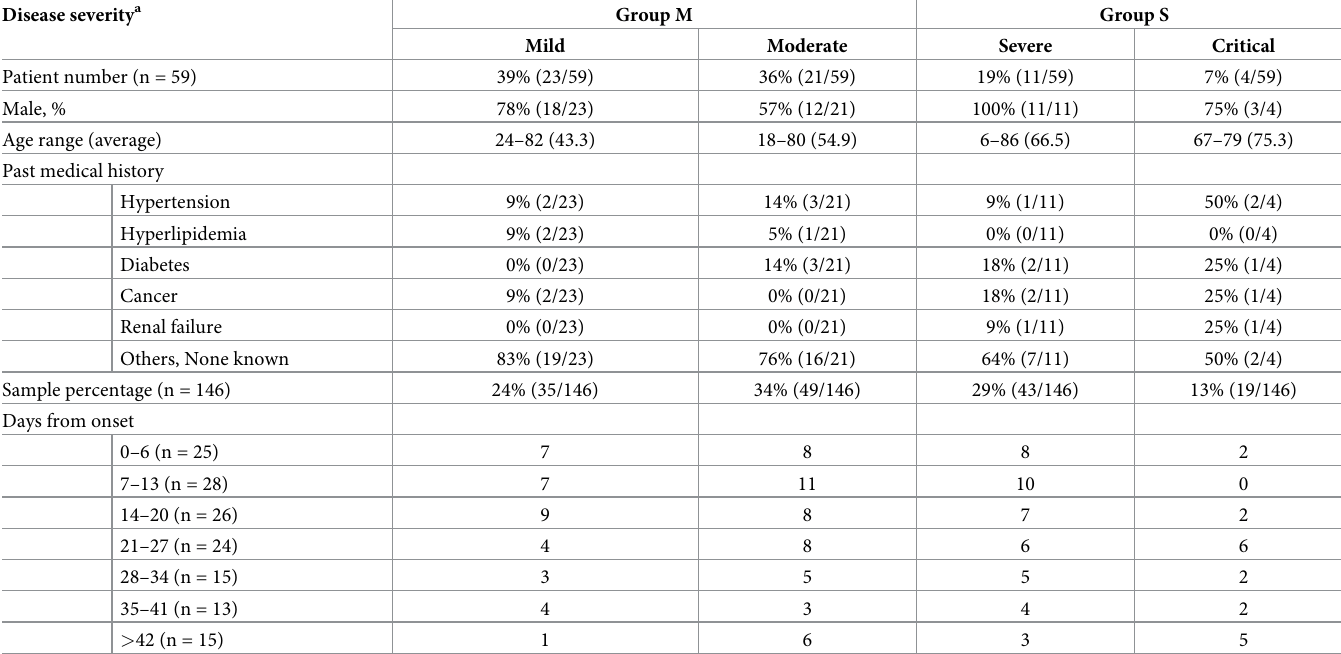
Table 1. Clinical characteristics of patients with COVID-19.